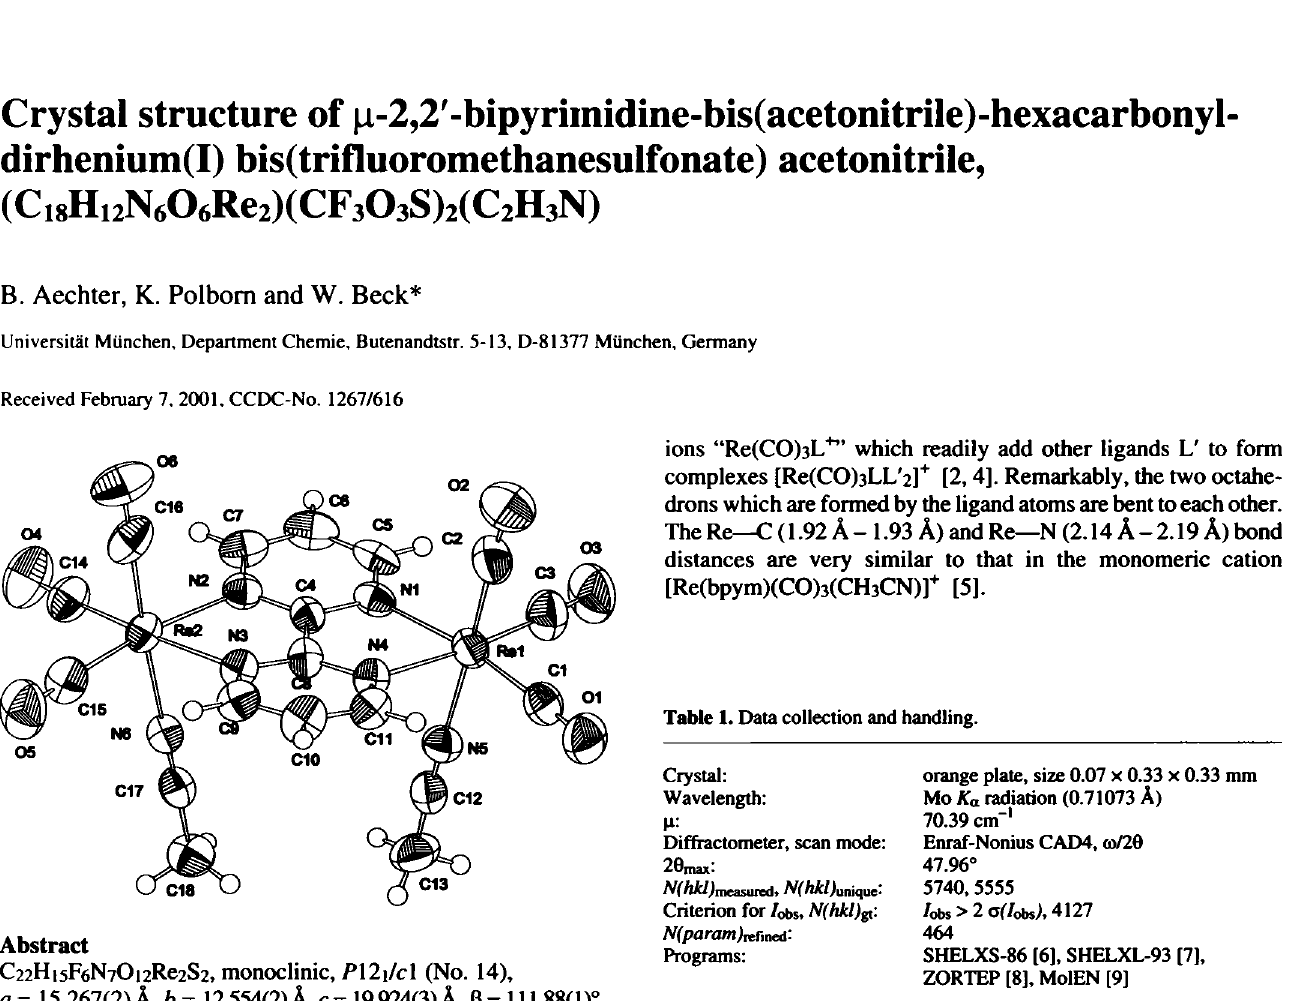
Table 2. Atomic coordinates and displacement parameters (in A 2